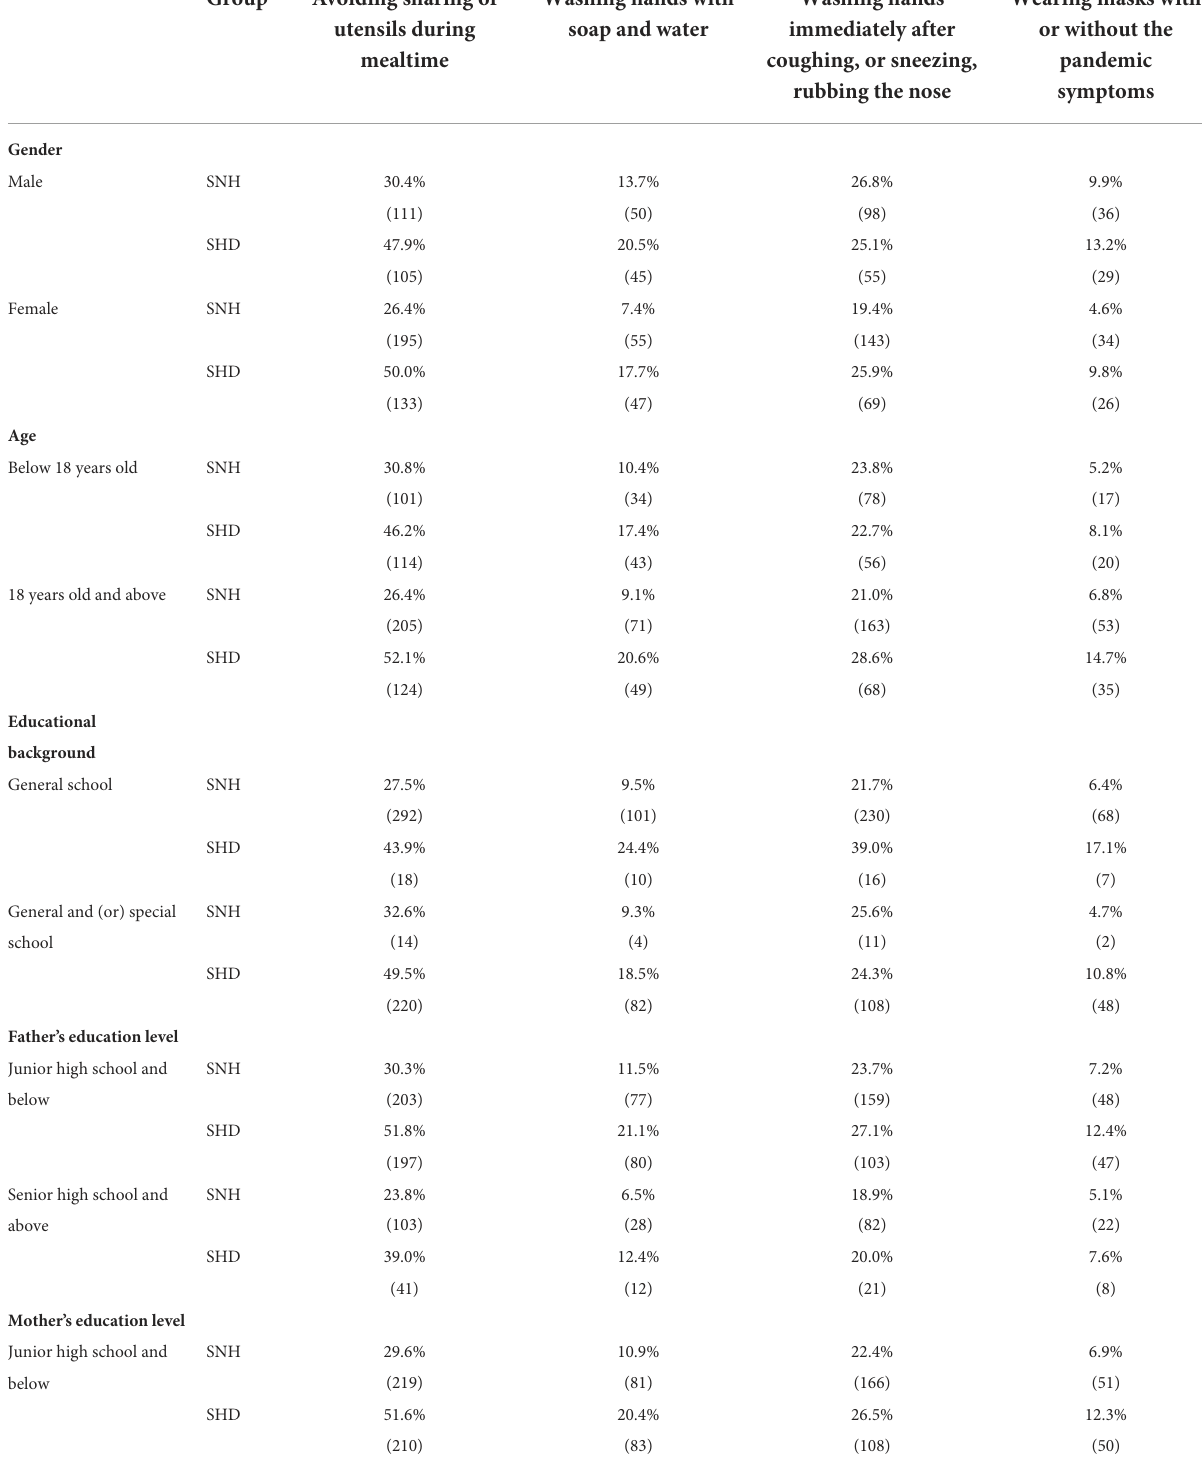
TABLE 1 The percentage of demographic variables with health behavior of ≤ 2 high-risk prevention scores among students with and without hearing disability. Group Avoiding sharing of Washing hands with Washing hands Wearing masks with utensils during soap and water immediately after or without the mealtime coughing, or sneezing, pandemic rubbing the nose